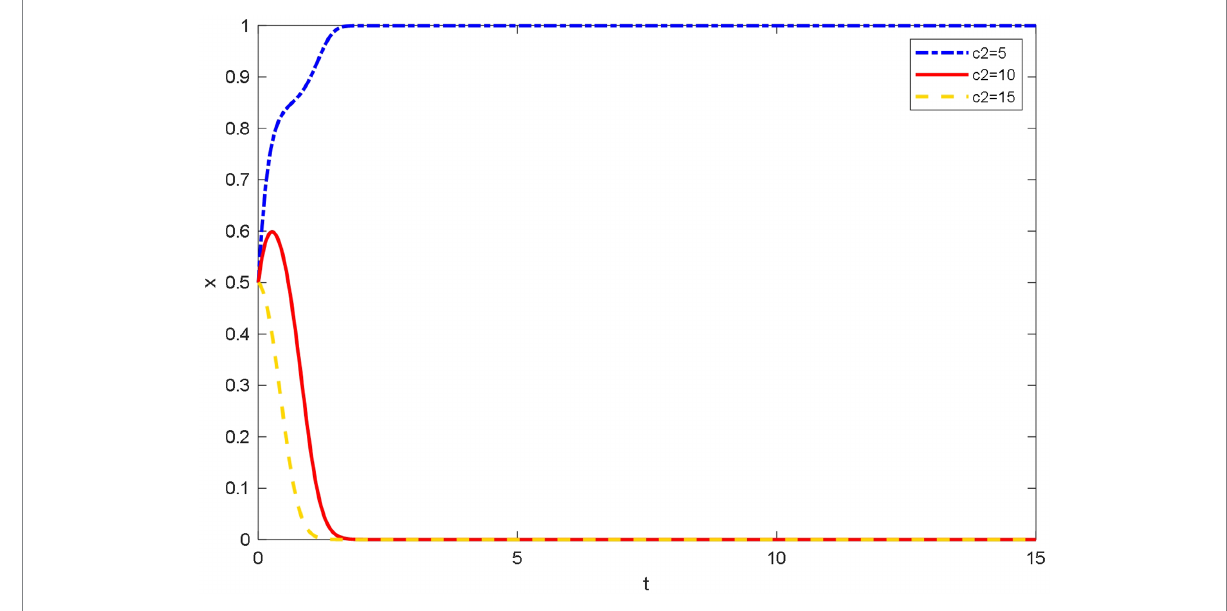
FIGURE 6 Evolutionary trajectory of doctors’ strategy selection under different time costs.